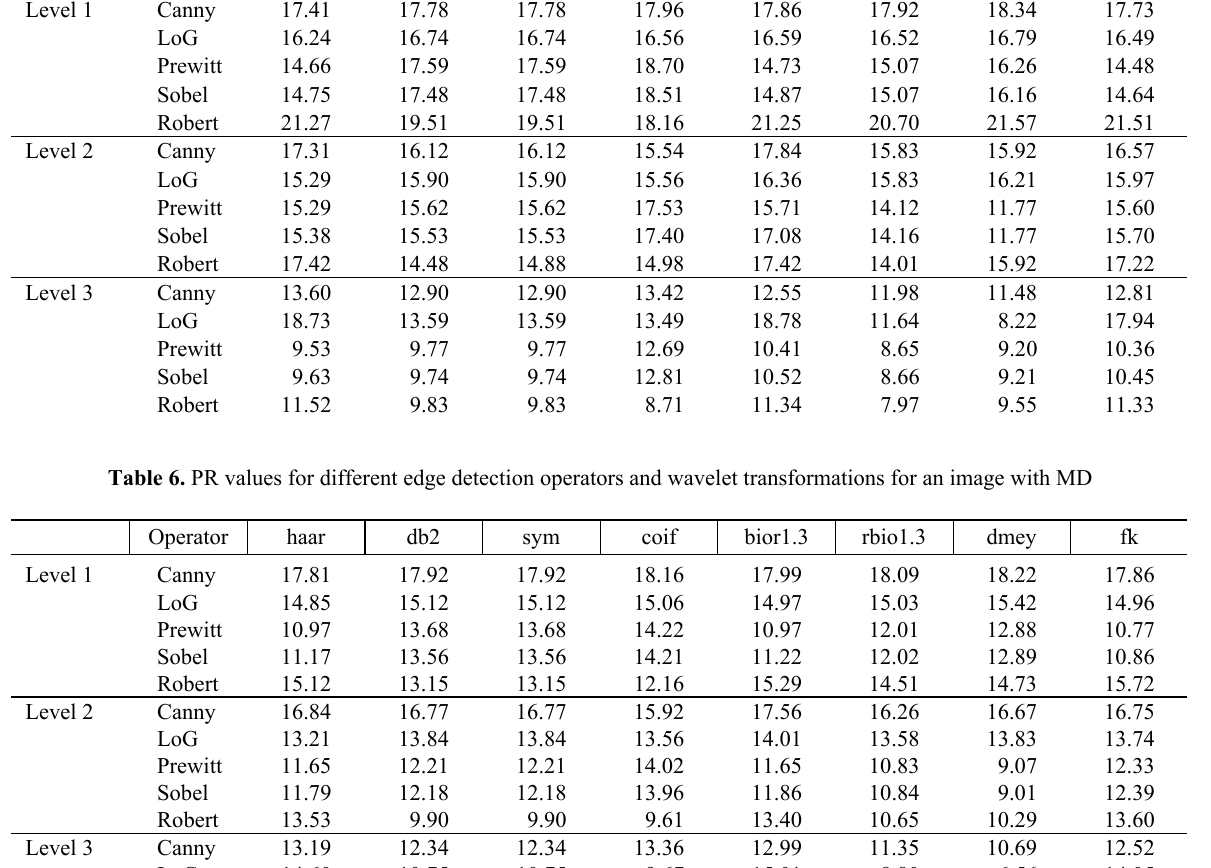
Table 5. PR values for different edge detection operators and wavelet transformations for an image with LD Operator